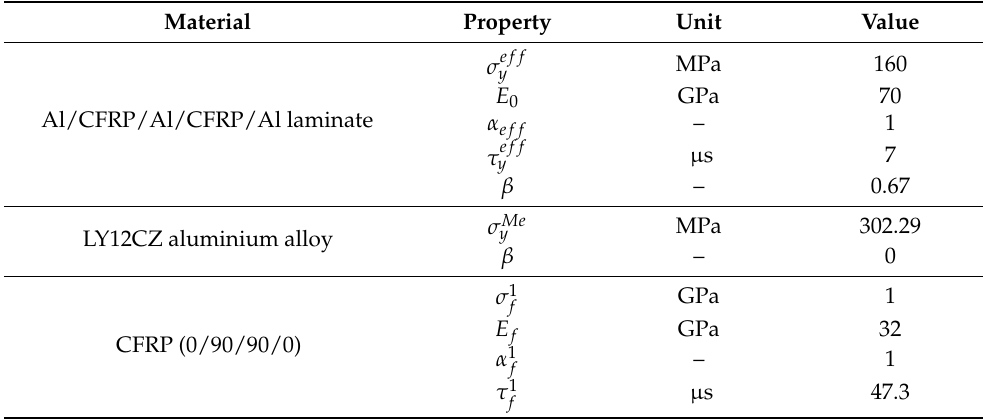
Table 5. Parameters of the model and materials [45] for the calculated deformation curves of the GLARE Al/CFRP/Al/CFRP/Al composite laminate in Figure